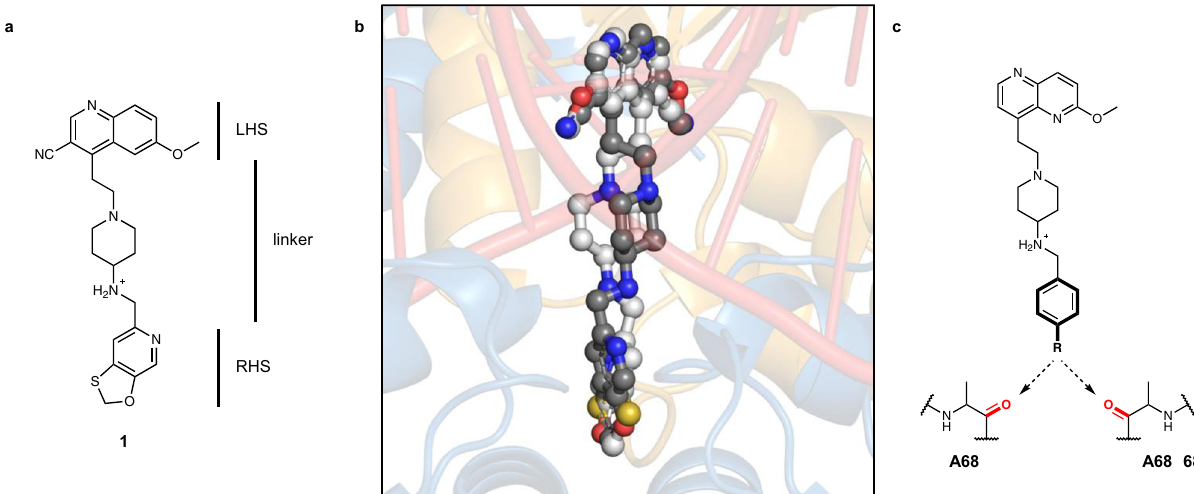
Fig. 1 NBTI structure and apparent static disorder in DNA gyrase-binding site. a Structure of the representative NBTI GSK299423 ( 1 ), indicating the main structural features of the molecule: the “ left-hand side ” (LHS) and the “ right-hand side ” (RHS) connected by linker 5,10 . b Two conformations of GSK299423 (represented as balls and sticks colour coded by element) ( 1 ) modelled as a superimposition of the two orientations due to static disorder 7,10 . c Our design strategy includes a simple phenyl RHS (represented by bold bonds), substituted in such a manner to allow binding by either halogen or hydrogen bonding with the backbone carbonyl oxygen of one of